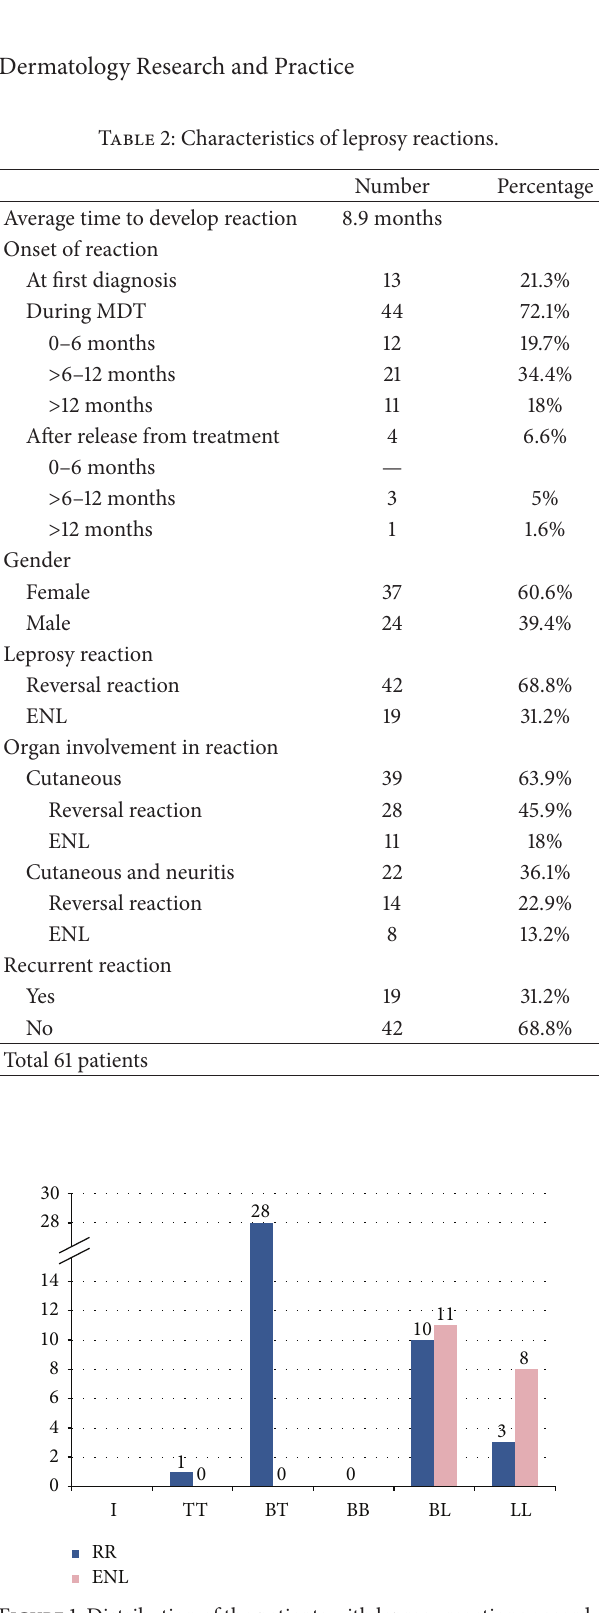
Figure 1: Distribution of the patients with leprosy reactions accord- ing to the clinical